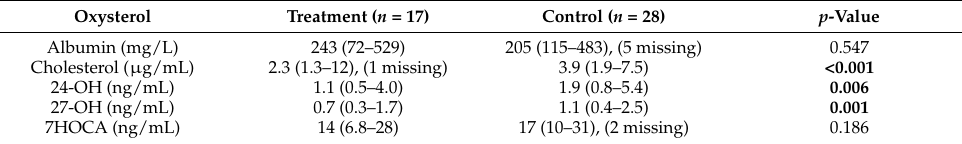
Table 1. Pre-operative metabolites in the treatment group vs. non-treated controls.